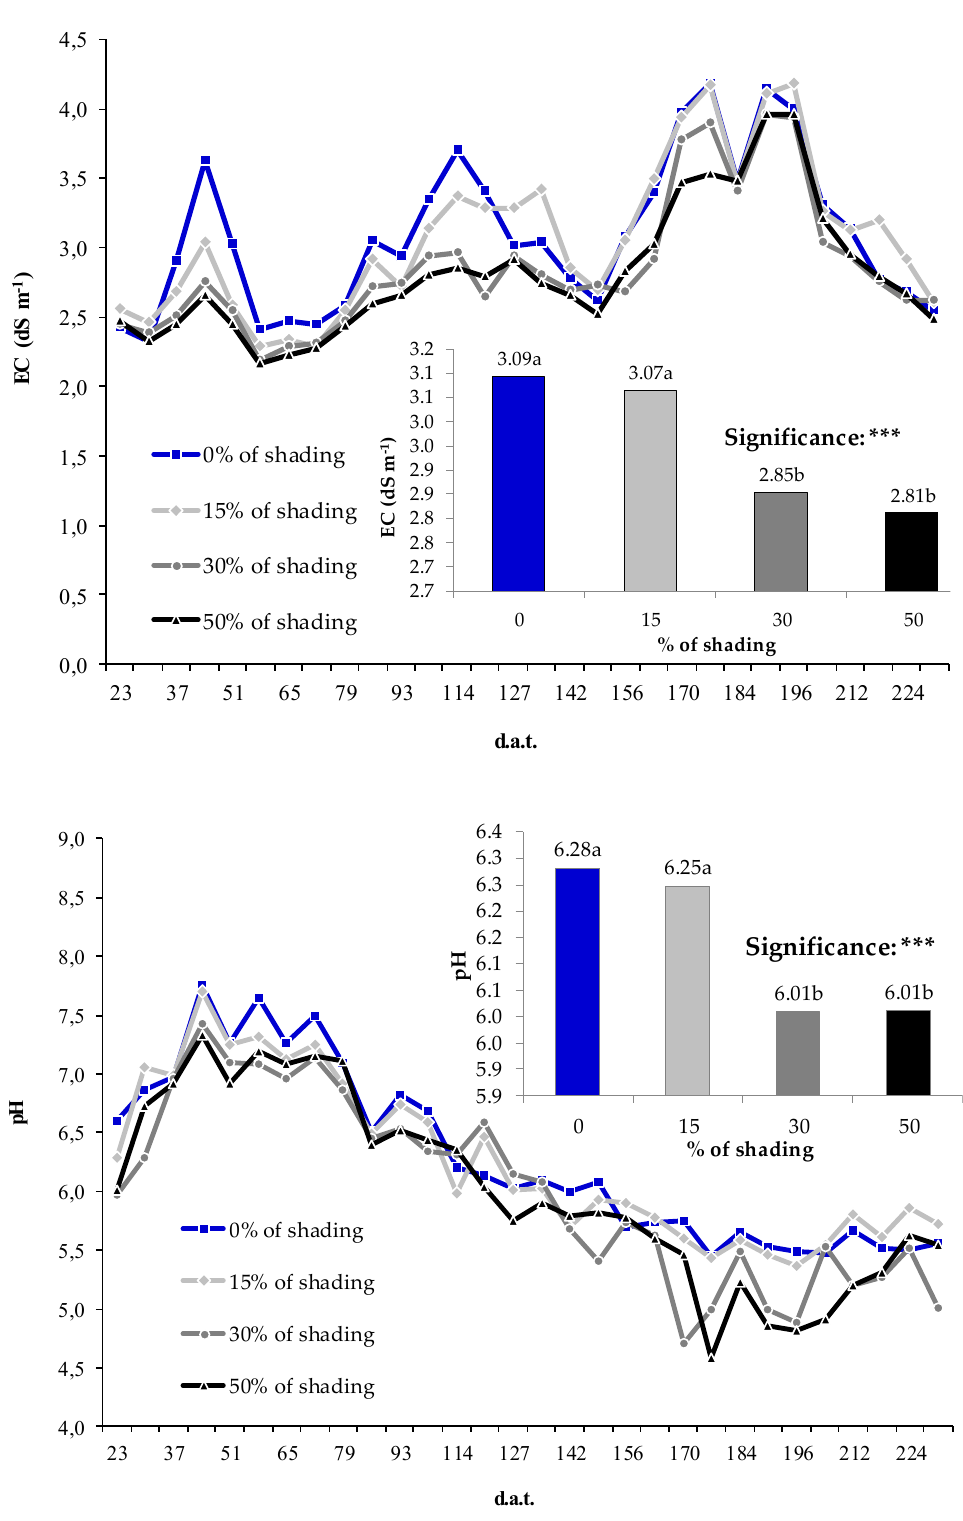
Figure 11. The pH and Electric Conductivity (EC) average evolution during the studied period in the substrate solution. In the period average, the analysis of the variance is performed according to the Yij model = µ + α i + β j + ε ij. The nomenclature n.s., *, ** and *** indicates not significant or significant for p ≤ 0.05, 0.01 and 0.001, respectively. Numerical values for each column followed by di ff erent letters denote statistical significance for p < 0.05 according to the corrected minimum significant di ff erences (LSD)